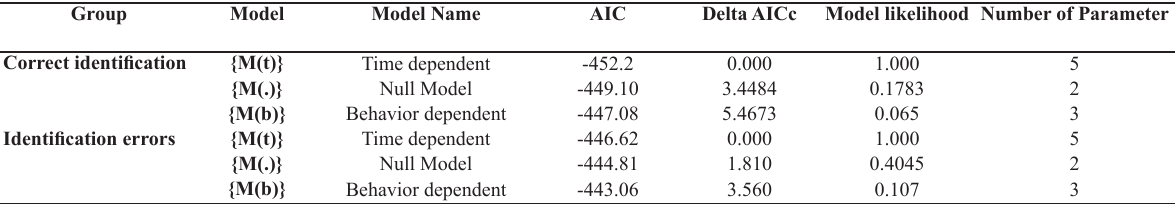
Table 2. Model selection for Amolops formosus abundance estimation based on AICc score under closed capture recapture frame work.